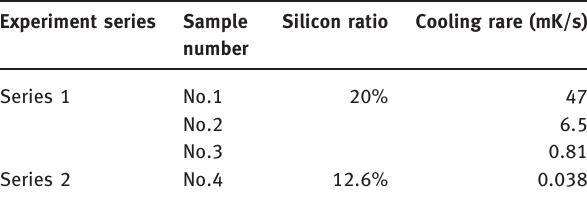
Table 2: Lists of samples.